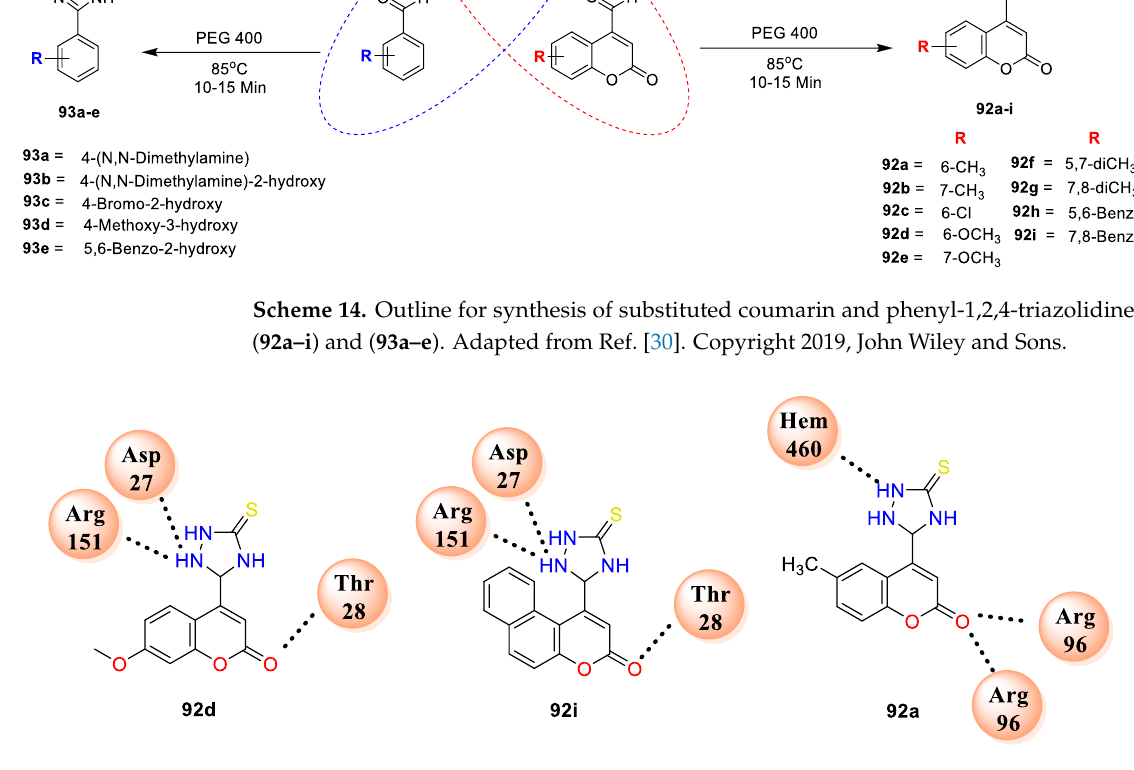
Figure 7. HB Interactions of compounds 92d and 92i with FabH target protein (PDB ID: 1HNJ) and 92a with CYP51 (PDB ID: 1EA1).